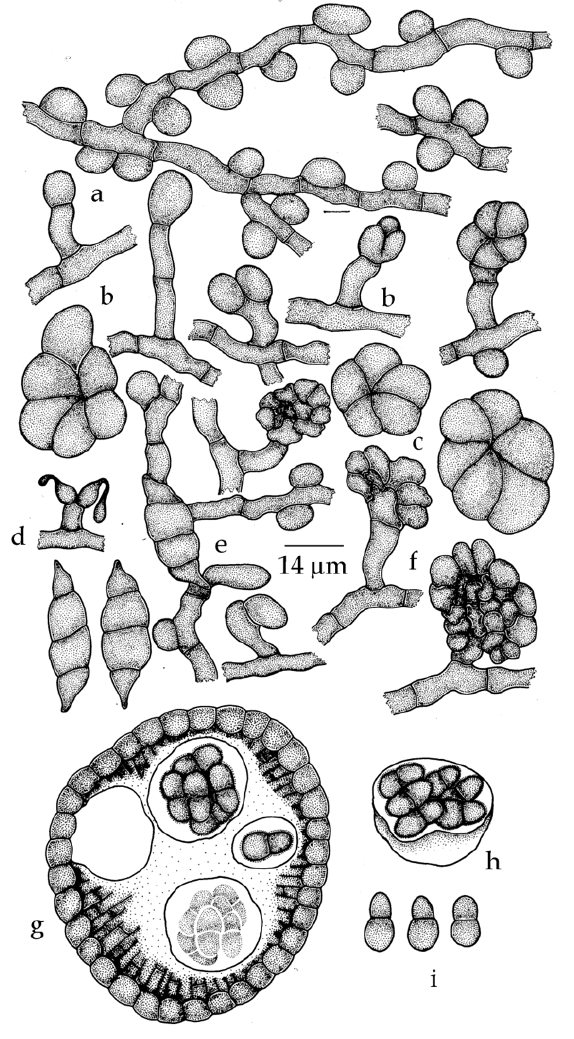
Figure 197 Schiffnerula vernoniae a.Appressoriate mycelium, b. Conidiophores, c. Conidia of Sarcinella , d. Conidiophore, e. Germinating conidia of Questieriella , f. Thyriothecium initials, g. Thyriothecium, h. Ascus, i.